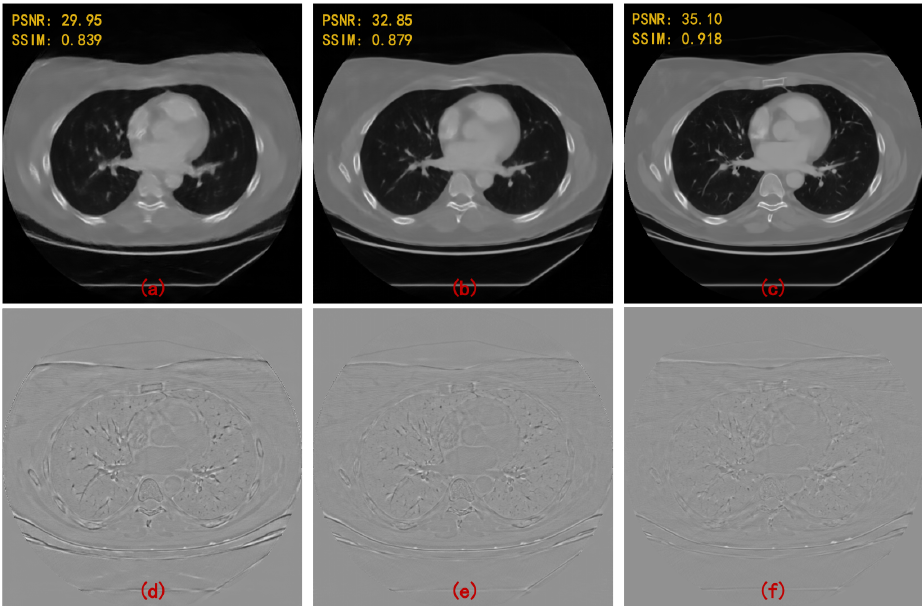
Figure 9. Reconstruction results and error maps of different wavelet-domain-based networks at 6 angular interval. ( a ) Dual-WCNN; ( b ) Dual-WUnet; ( c ) Dual-MWCNN; ( d ) error map of ( a ); ( e ) error map of ( b ); and ( f ) error map of ( c ).